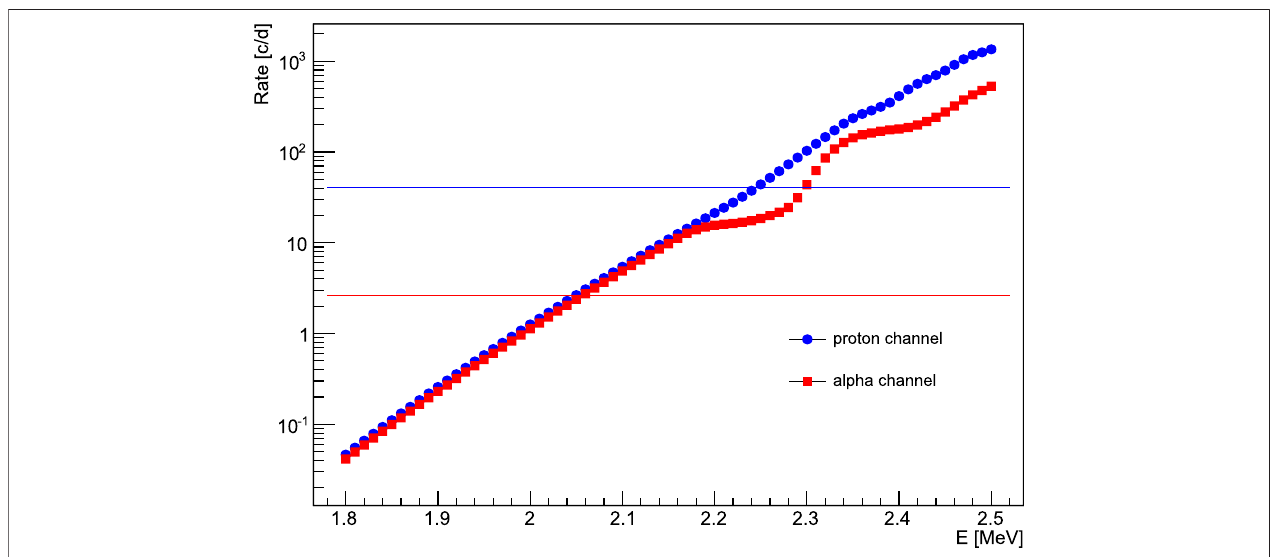
FIGURE 10| Counting rate, in counts per day, obtained considering data provided by Spillane et al. (2007), a c detection ef fi ciency of6% and 2% for 440 keV and 1636 keV c energies,respectively,andabeamcurrentof50 – 150 μ A.Thetwohorizontallinesrepresentatypicalrateof c backgroundmeasuredatLNGSwithashielded setup Caciolli et al. (2009) (blue and red lines for 440 keV and 1636 keV c energies,